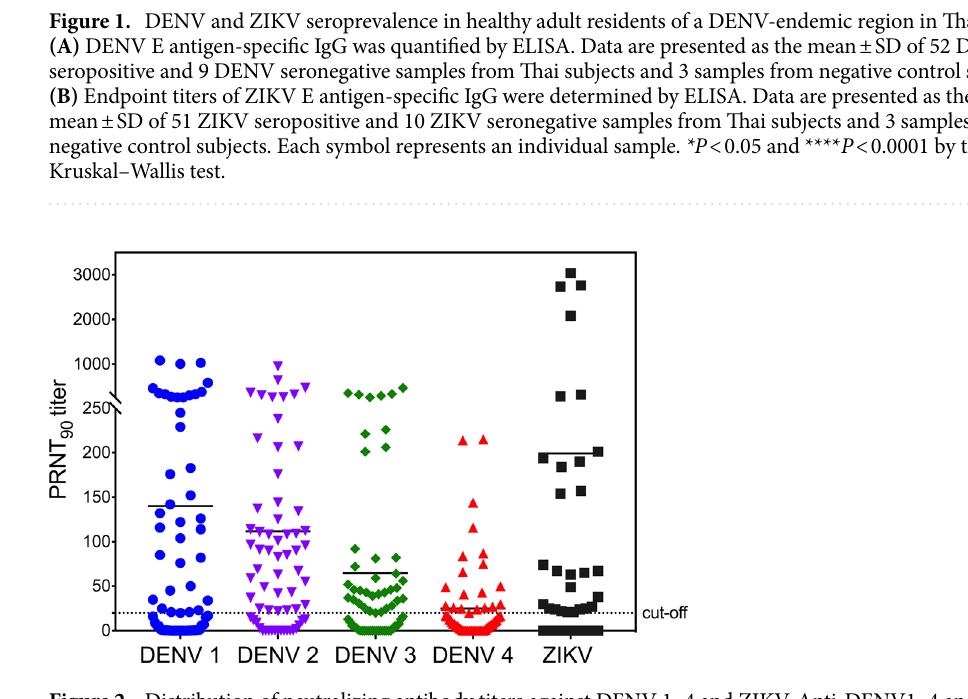
Figure 2. Distribution of neutralizing antibody titers against DENV 1–4 and ZIKV. Anti-DENV1–4 and ZIKV NAbs were measured by PRNT. The dashed line indicates PRNT 90 = 20, which was the cutoff value for positive/ negative stratification of sera. Each symbol represents an individual sample. Horizontal bar represents the mean. N =